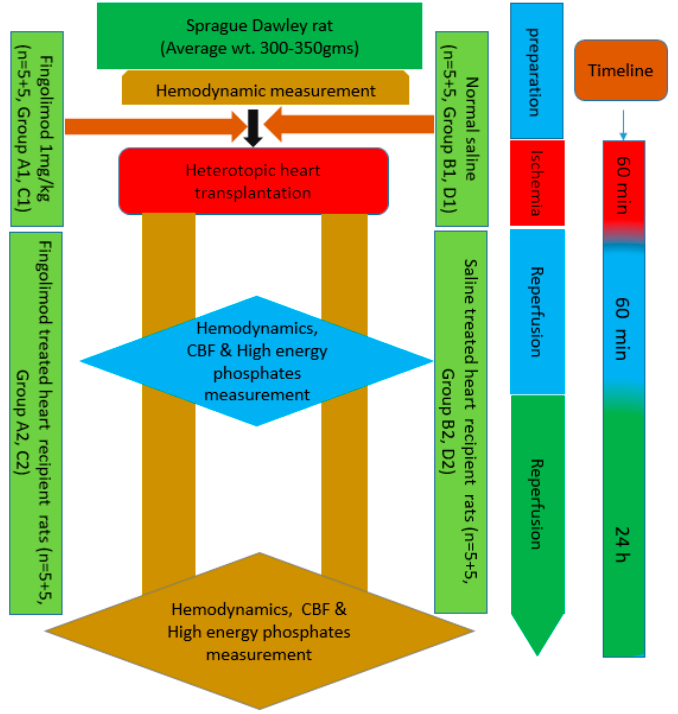
Figure 7. Experimental design.